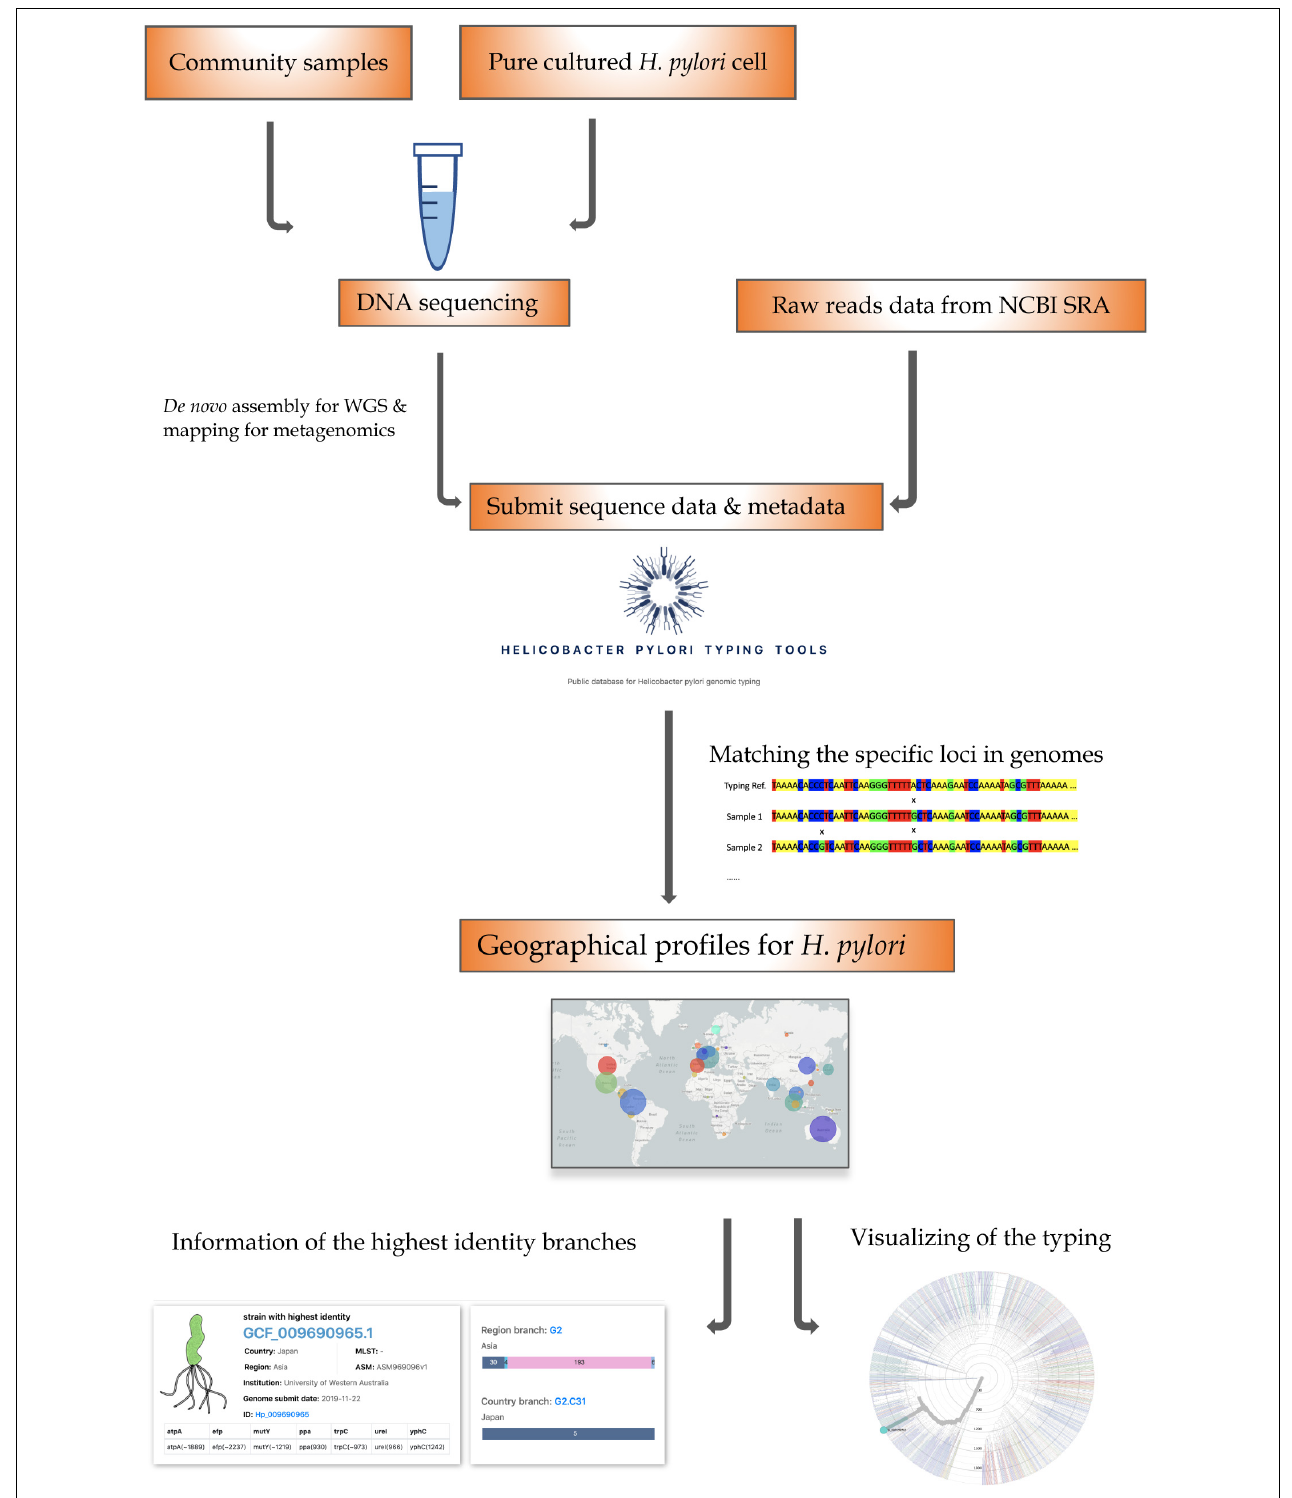
FIGURE 4 | The Hp TT workflow. The SNP-based genotyping approach can be used with the Whole Genome Sequencing (WGS) data, which can be acquired in the following ways: DNA can be extracted from a pure cultured bacterial cell with WGS data or a community sample with metagenomic sequencing data. After being sequenced by an appropriate platform, the assembled genomes can be directly submitted to our database. In addition, the public assembled data can also be directly submitted to our database. The downstream analyses of the aligned sequence data can be linked to the phylogenetic and geographic page.